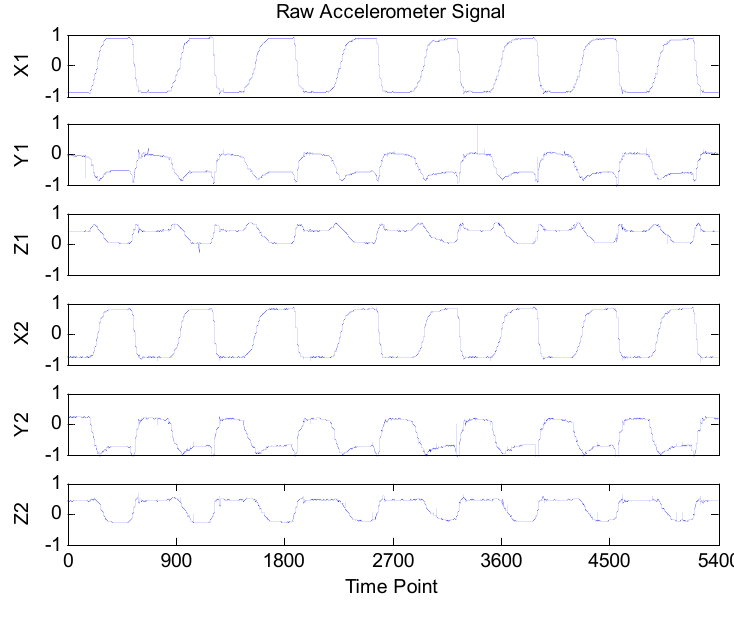
Figure 4. Raw accelerometer signals.